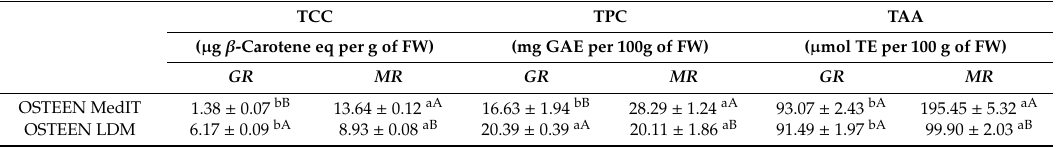
Table 1. Total carotenoid content (TCC), total polyphenolic content (TPC) and Total Antioxidant Activity (TAA) in green-ripe (GR) and mature-ripe (MR) fresh Mediterranean Italian (MedIT) and imported (LDM) “Osteen” mango fruit. Values represented as mean ± SE ( n = 15). For each line, di ff erent lowercase letters indicate significant di ff erences between the ripening stage mature-green (GR) and mature-ripe (MR) of each mango fruit (fresh Mediterranean Italian or imported); for each column, uppercase letters, within the same series (GR or MR) indicate significantly di ff erences between fresh Mediterranean Italian and imported fruit.